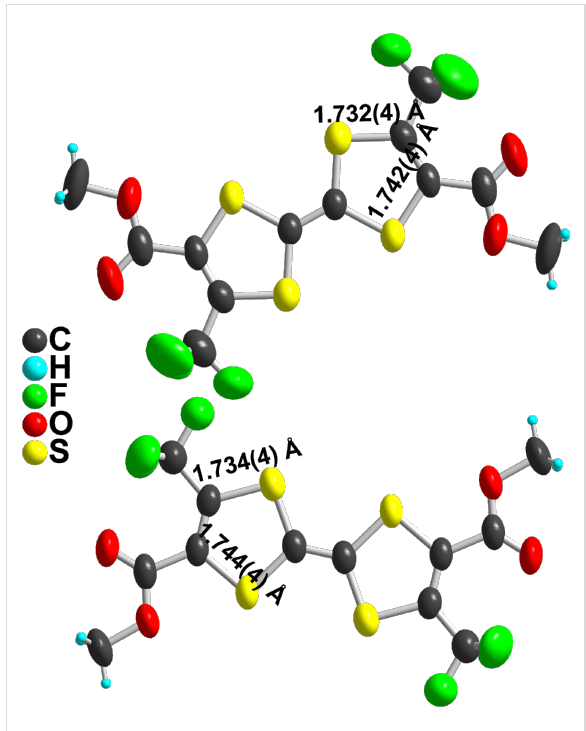
Figure 5: View of the two crystallographically independent 4bc mole- cules. Thermal ellipsoids are shown at the 50% probability level.